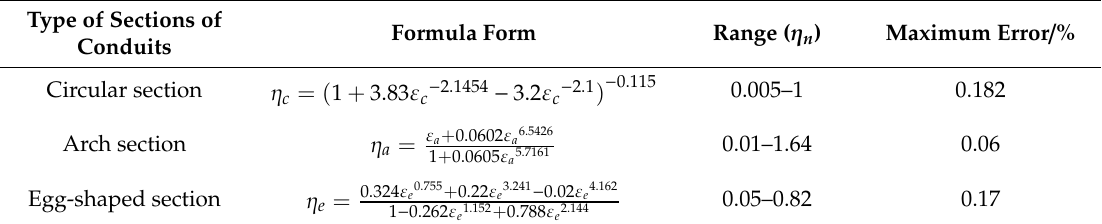
Table 1. The formulas of critical depths for three types of